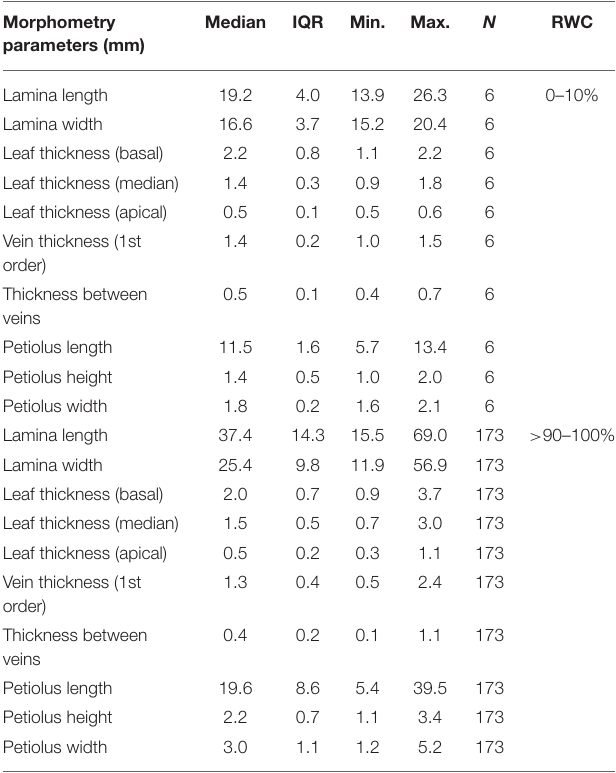
TABLE 1 | Leaf morphometric alterations of R. myconi from full turgescence to desiccation. Morphometry parameters